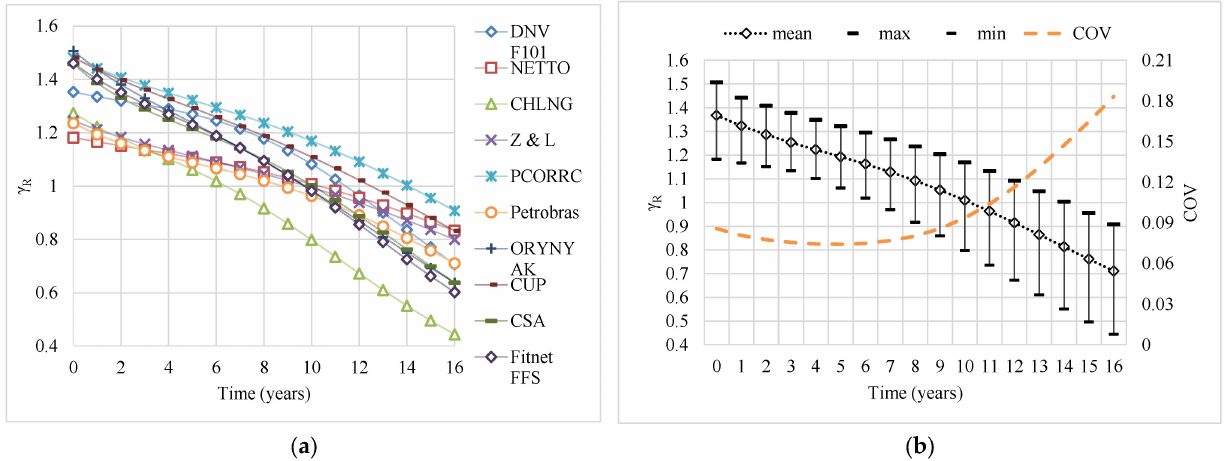
Figure 4. ( a ) PSF ( γ R ) for medium steel grade as a function of elapsed life and ( b )mean, range and uncertainty of